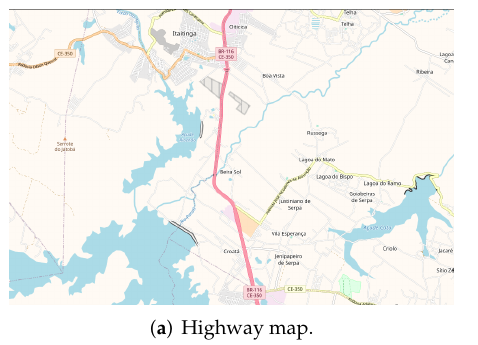
Figure 3. Highway scenario.